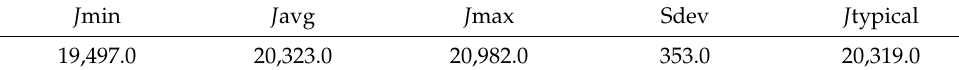
Table 7. Results of the closed-loop simulation series using the Controller with EAv2.